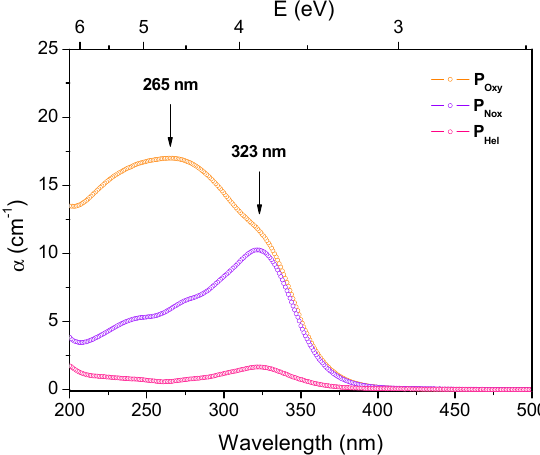
Figure 2. Ce-doped preforms optical absorption spectra.